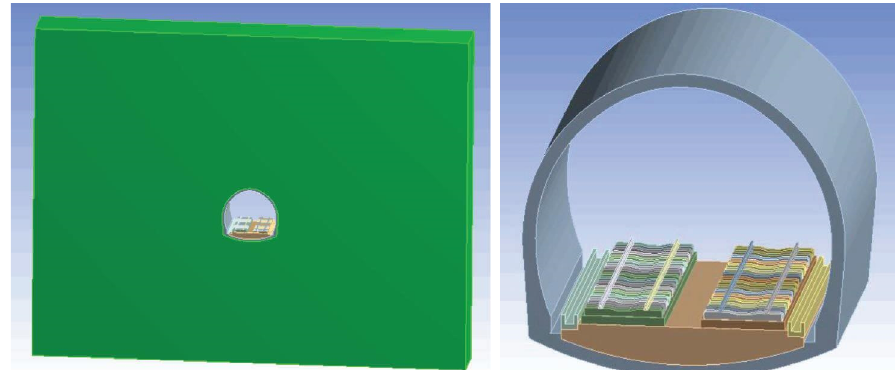
Figure 16: Fatigue damage analysis based on fnite element method.